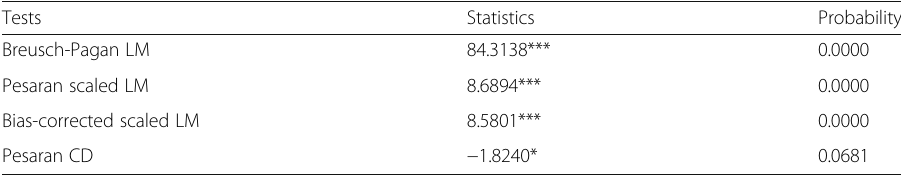
Table 3 Cross-sectional dependence tests Tests